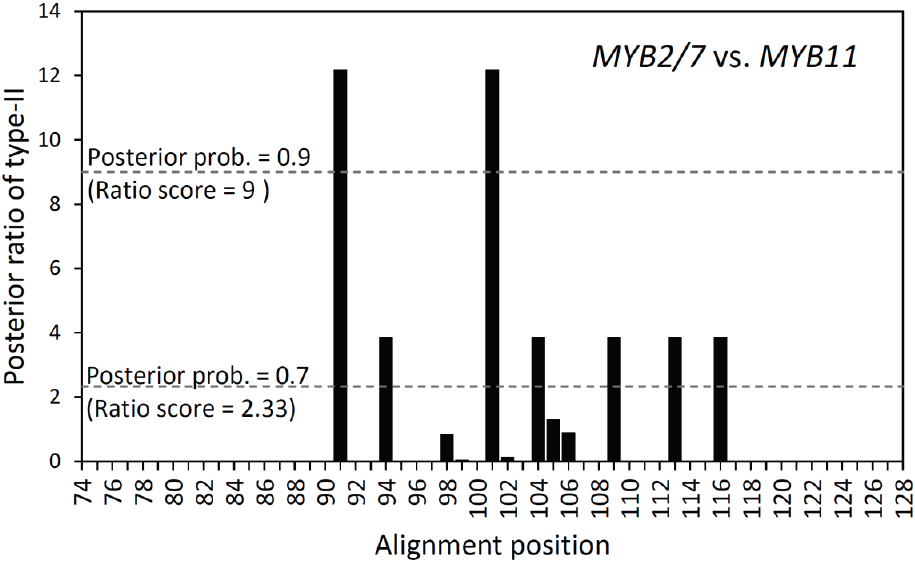
Figure 3. Site-specific profile for type-II functional divergence between Scutellaria MYB2 / 7 and MYB11 . Horizontal dot lines indicate the criteria of posterior probability 0.9 and